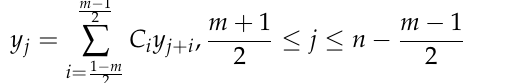
(blue dot). The x-axis corresponds to the time in minutes of the preheating phase IF = 1.